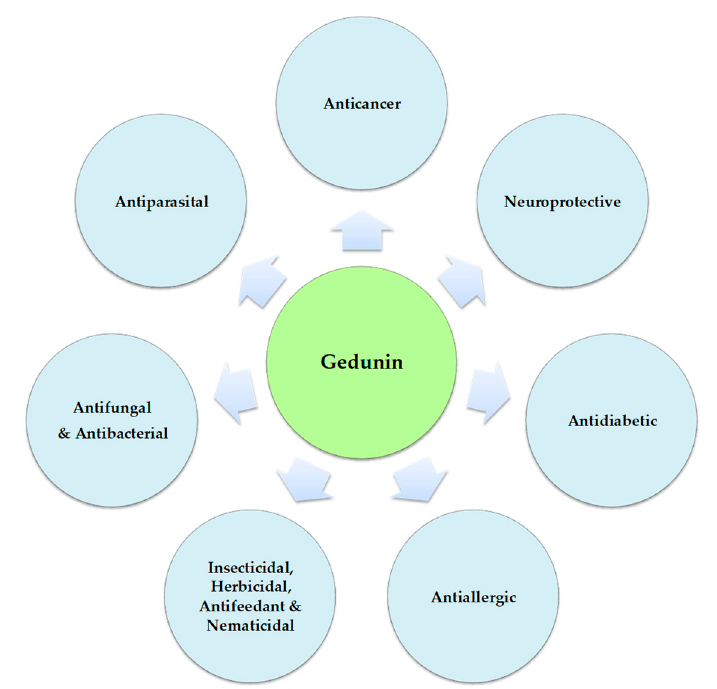
Figure 1. Biological activities of gedunin.